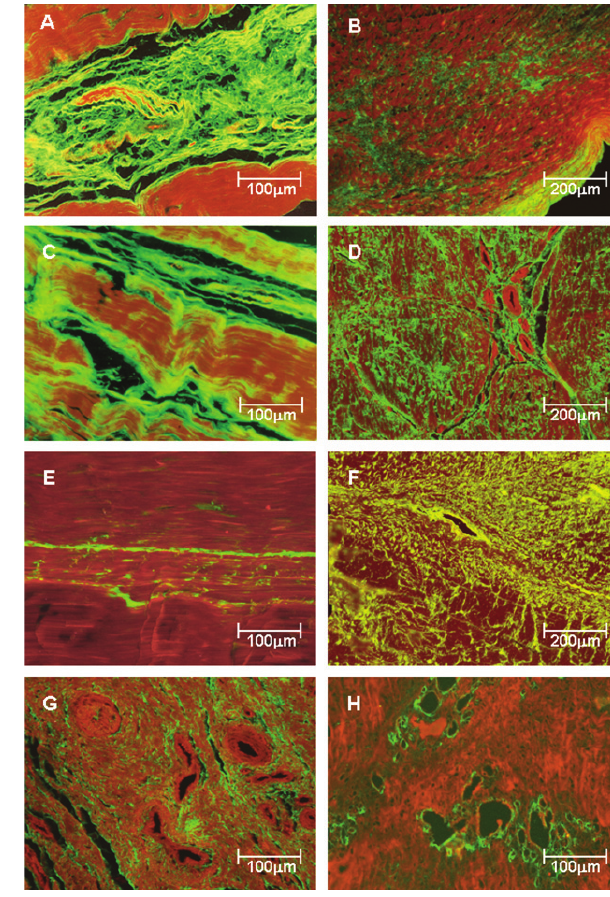
Figure 2 - Type I, III and V collagenous fibers in tendon controls (panels A, C and E) and posterior tibial tendon dysfunction (PTTD) patients (panels B, D, F, G and H) labeled with fluorescein and observed under a fluorescent microscope. Control tendons show parallel orientation of type I (A) and III (C) collagen and strong green fluorescence and a finely reticulated type V collagen (E) network in the interstitium and basement membranes of vessels, coincident with the maintenance of the architecture of the tendons. In contrast, PTTD shows distorted architecture and a diffuse increase of birefringence for all three types of collagen. Type I collagen birefringence is discrete and diffusely distributed in pathologic tendons (B). Type III has the same distribution found for type I but is more prominent and thus defines the fibrosis process installation (D). Type V collagen was mostly found in the vessel walls and around them, resulting in a finely reticulated network (F) when compared to type III fibers. In panels G and H, the strong birefringence of type III and V collagen in the periadvential areas with more vascular density are shown Original magnification X 100 in panels B, D and F; X200 in panels A, C, E, G and H)